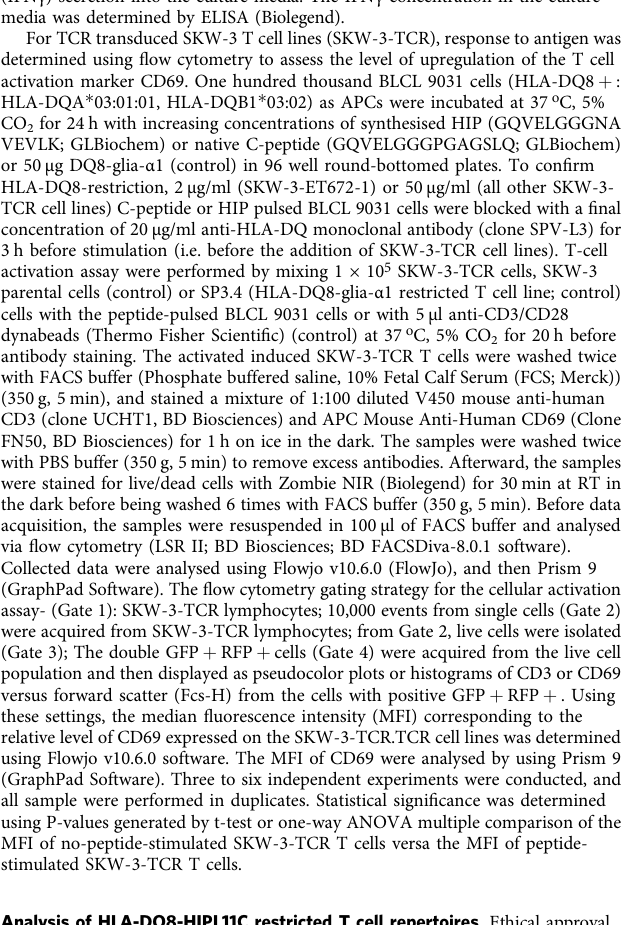
(Supplementary Table 8). PCR products were then puri fi ed and sequenced on an ABI 3730 DNA Sequencer and TRAV and TRBV gene usage determined using the IMGT database search engine IMGT/V-QUEST (http://www.imgt.org/ IMGT_vquest/vquest?livret = 0&Option = humanTcR) 47